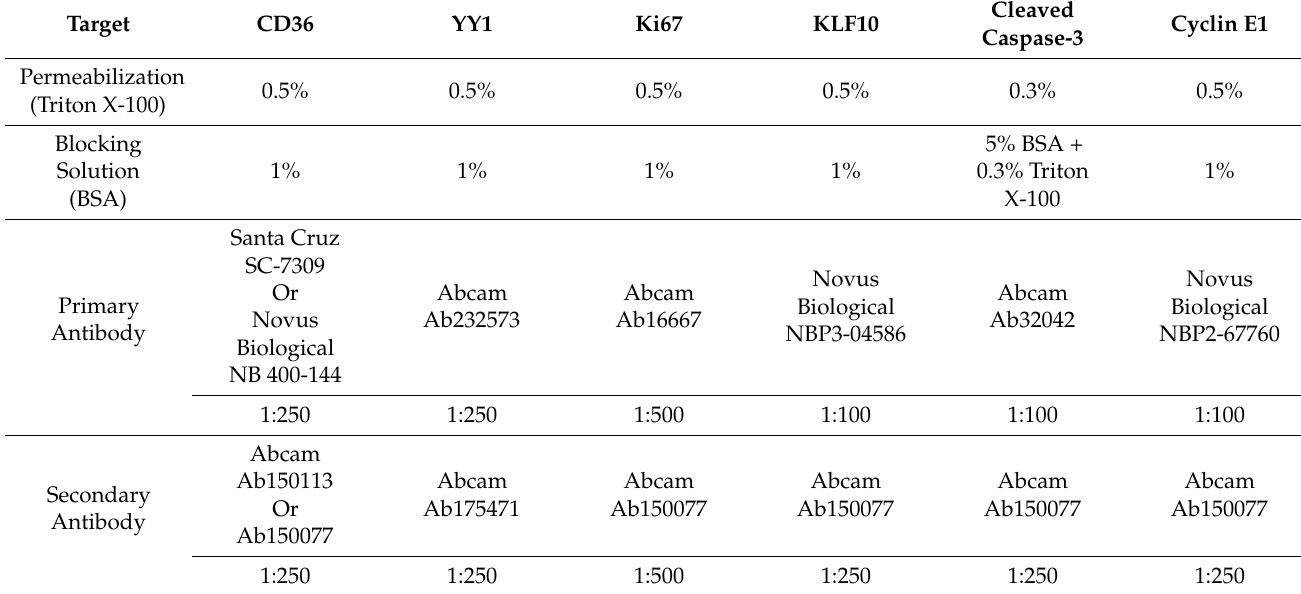
Table 1. Details of the immunofluorescent staining for each molecular